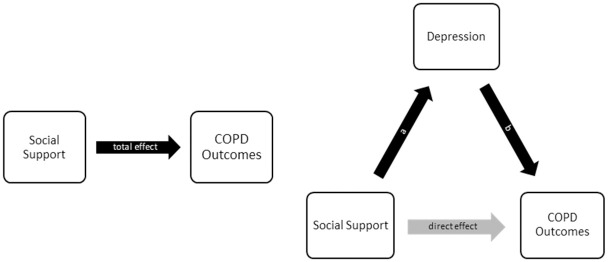
Mediation proportion as the percentage of total effect “Explained” (or Reduced) by the mediator, or equivalently, 1 –direct effect/total effect = mediation proportion.